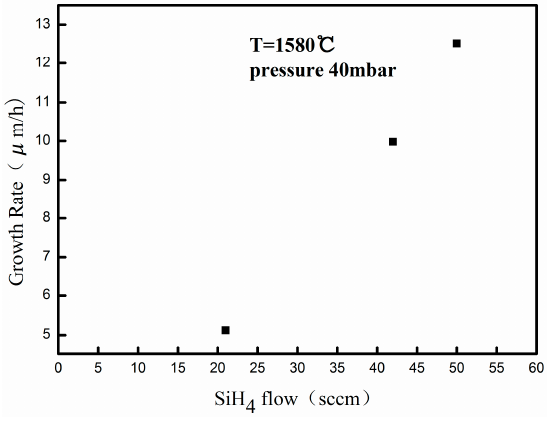
Figure 2. Growth rate of 4H-SiC epitaxial layers for various silane flow rate.